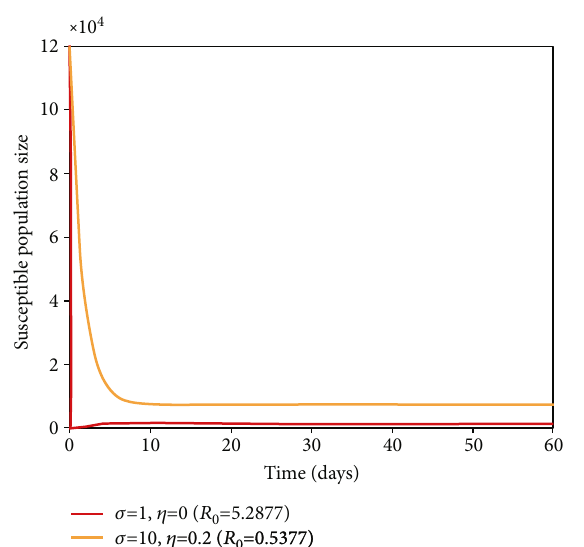
Figure 11: The e ff ect of σ on R